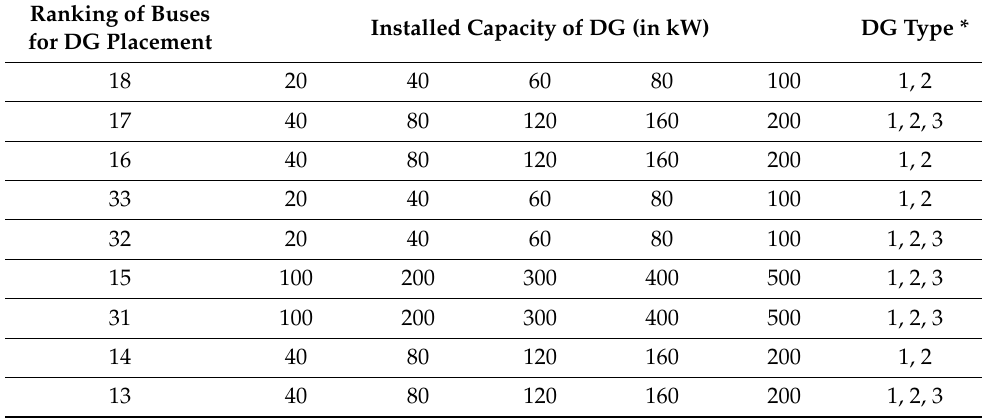
Table 2. Candidate schemes for a different type of DGs placement and their sizing. Ranking of Buses for DG Placement